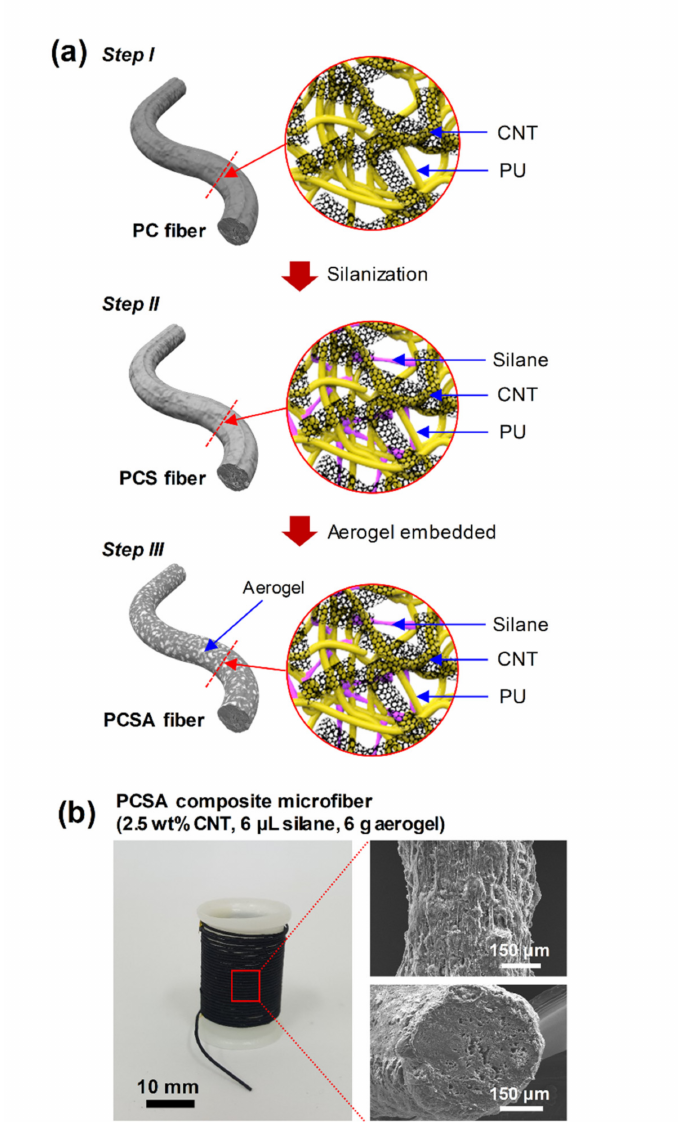
Figure 1. ( a ) Design of the di ff erent composite microfibers. ( b ) Left: photograph of the fabricated polyurethane-carbon nanotube-silane-aerogel (PCSA) composite microfiber (carbon nanotubes (CNT) 2.5 wt%, silane 6 µ L, aerogel 6 g) wound on a spool. Right: FESEM images of the surface and cross-section of the composite